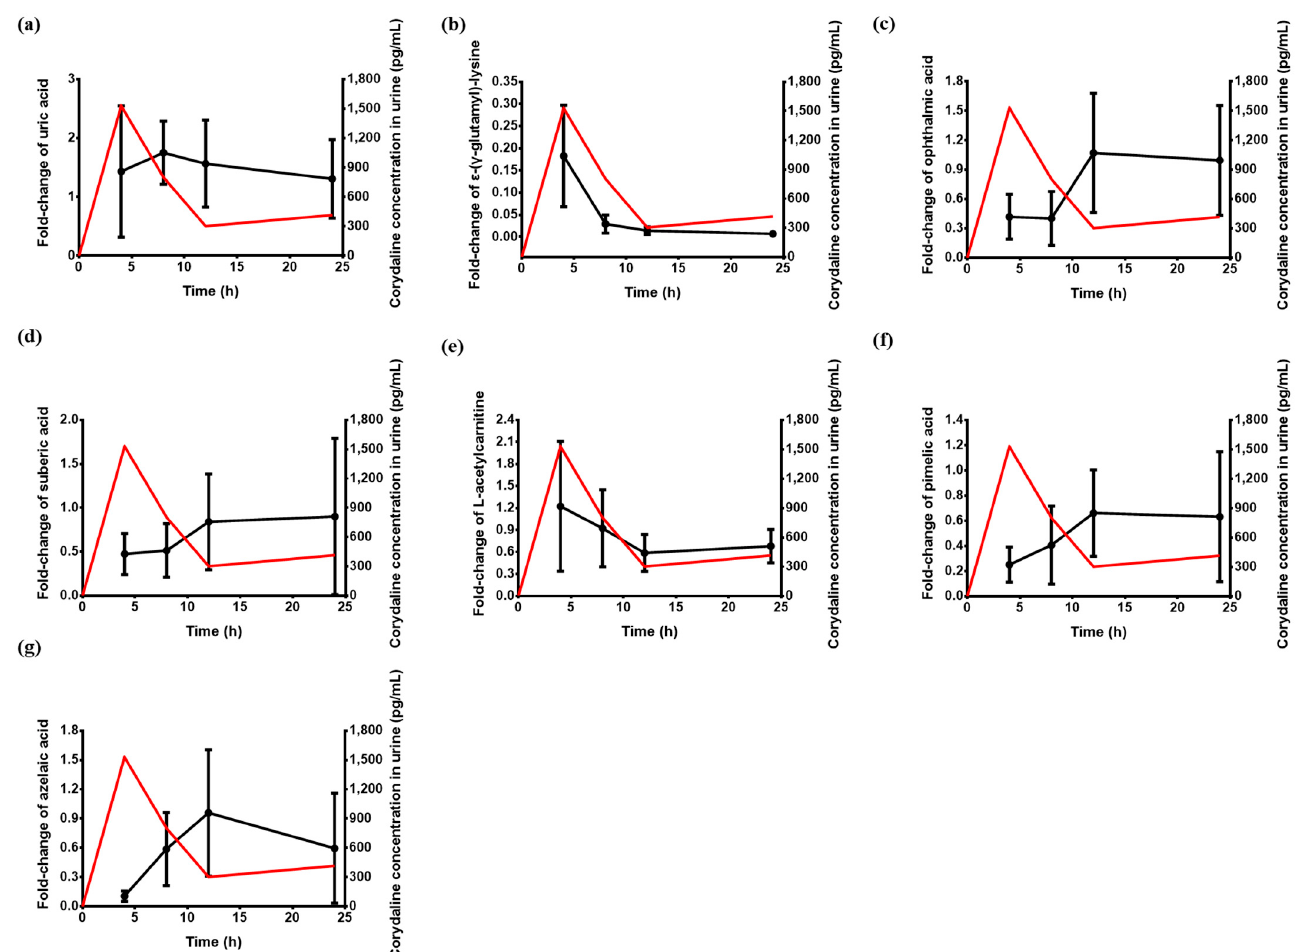
Figure 4. The mean concentration-time profiles of corydaline and mean fold-change of seven candidate in urine after administration of 90 mg DA-9701 (n = 16). ( a ) uric acid; ( b ) ε -( γ -glutamyl)-lysine; ( c ) ophthalmic acid; ( d ) suberic acid; ( e ) L -acetylcarnitine; ( f ) pimelic acid; and ( g ) azelaic acid. x -axis presented time (hours) against peak area for candidates (left y -axis) and corydaline concentration in urine (right y -axis). All data points are presented as average peak area with error bars.